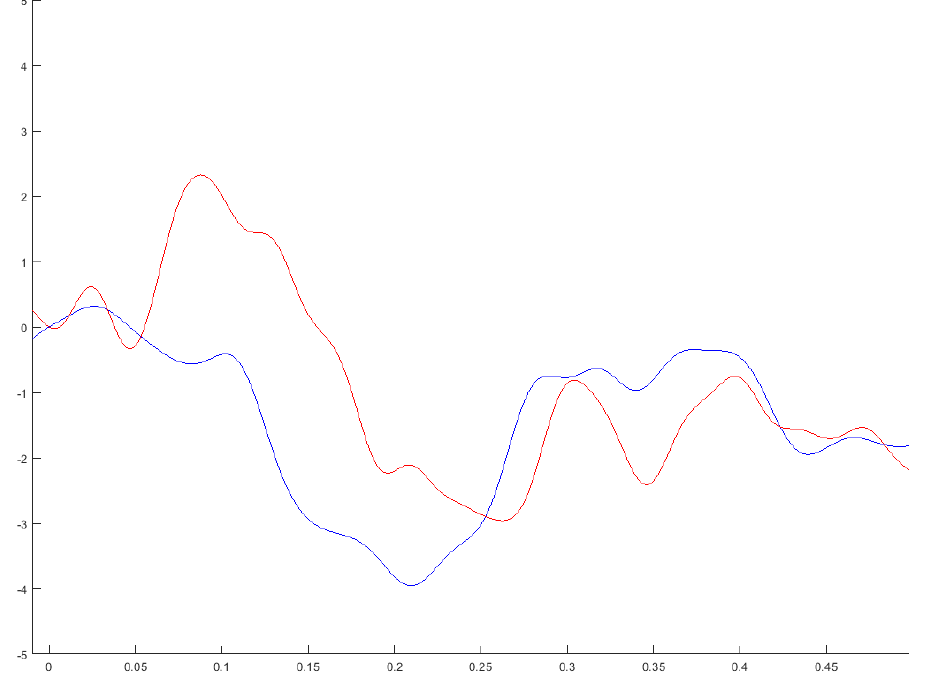
Figure 2. Grand averaged difference waveforms for changes in pitch under frontal Fz electrode in schizophrenia patients (red line) versus healthy controls (blue line). The X axis indicates a 0.5 s window post-stimulus with a 0.01 s pre-stimulus time window. Y axis represents the MMN amplitudes (5 to − 5 µV). MMN difference waveforms were not statistically different.